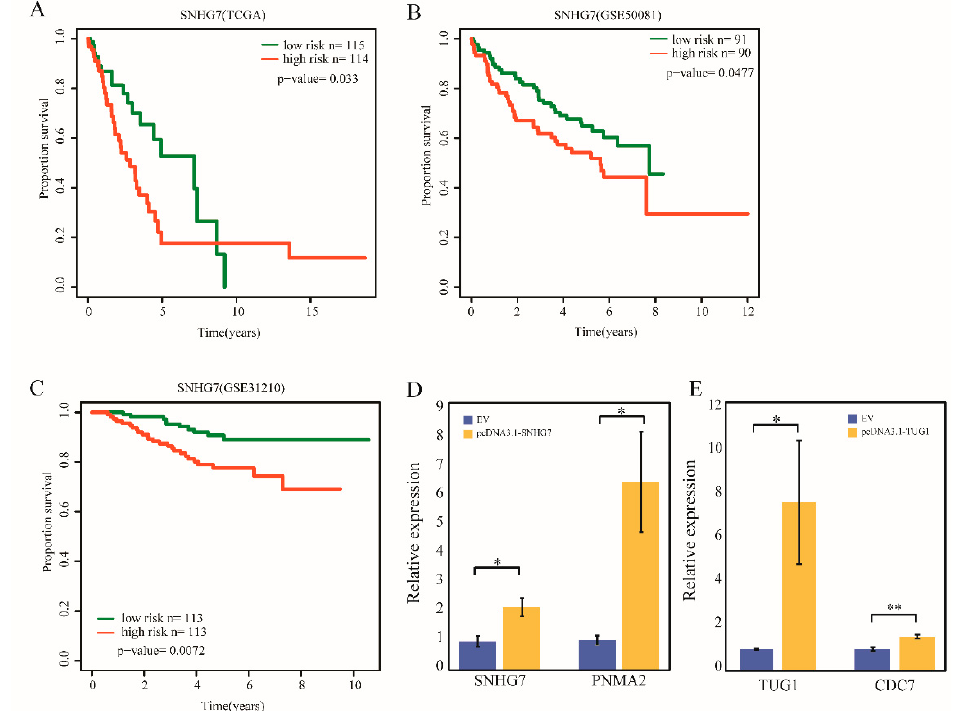
Figure 6. Validate the SNHG7 signature and overexpress lncRNA perturbators in LUAD. ( A – C ) Kaplan–Meier estimates the overall survival using the lncRNA perturbator SNHG7 in the TCGA LUAD dataset, independent GSE50081 dataset and GSE31210 dataset. ( D ) The expression of SNHG7 and PNMA2 was detected in A549 cell line transfected with pcDNA3.1- SNHG7 and empty vector by qRT-PCR (* p < 0.05; ** p < 0.01; *** p < 0.001; Student t -test). ( E ) The expression of TUG1 and CDC7 was detected in the A549 cell line transfected with pcDNA3.1- TUG1 and empty vector by qRT-PCR (* p < 0.05; ** p < 0.01; *** p < 0.001; Student t -test. Lung adenocarcinoma, LUAD.